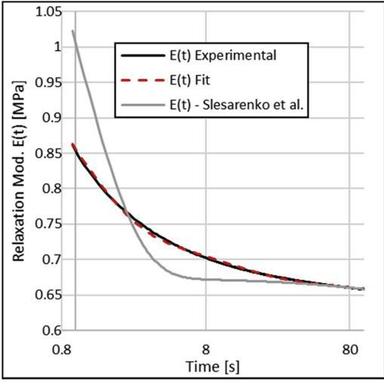
Comparison between the relaxation test results and our Prony series prediction and that reported in.